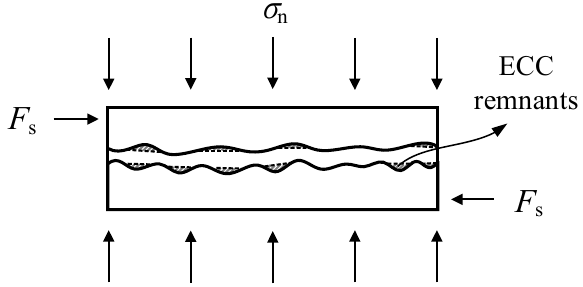
Figure 22. ECC remnants in the indentation of stone surface during stage Ⅳ .